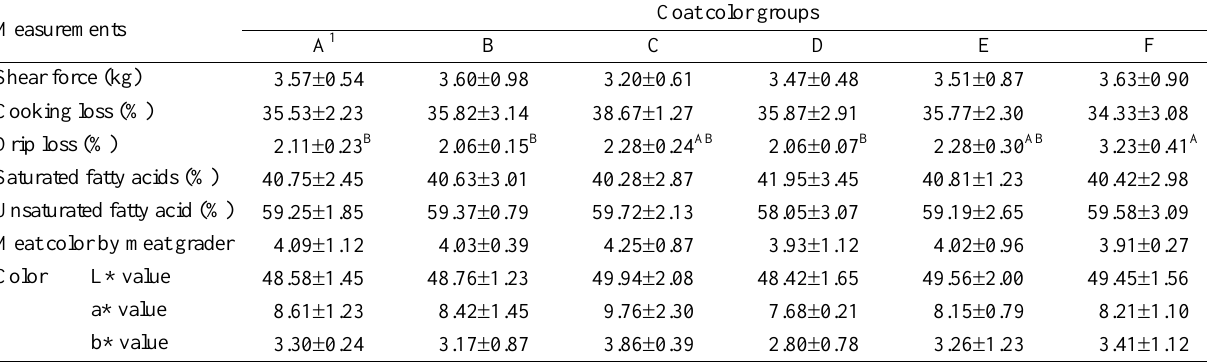
Coat color groups